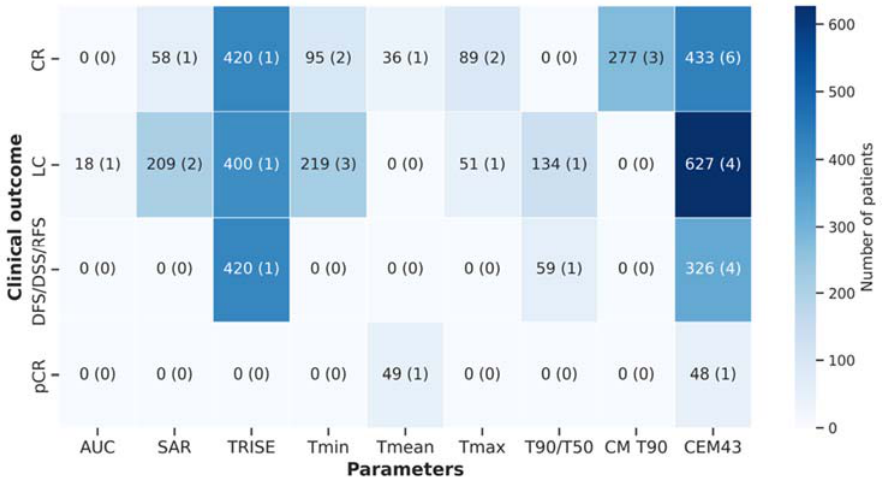
Figure 8. Heatmap showing the association of clinical outcome with temperature and thermal dose parameters in terms of the number of patients. Brackets correspond to the number of studies. CR: complete response; DFS: disease-free survival; DSS: disease-specific survival; RFS: relapse-free sur ‐ vival; LC: local control; pCR: pathologic complete response; AUC: area under the curve; SAR: spe ‐ cific absorption rate; Tmin: minimum temperature; Tmax: maximum temperature; T90/T50: temper ‐ atures exceeded by 90%/50% of the measured temperature points; CM T90 cumulative minutes T90; CEM43: cumulative minutes at 43 °C.